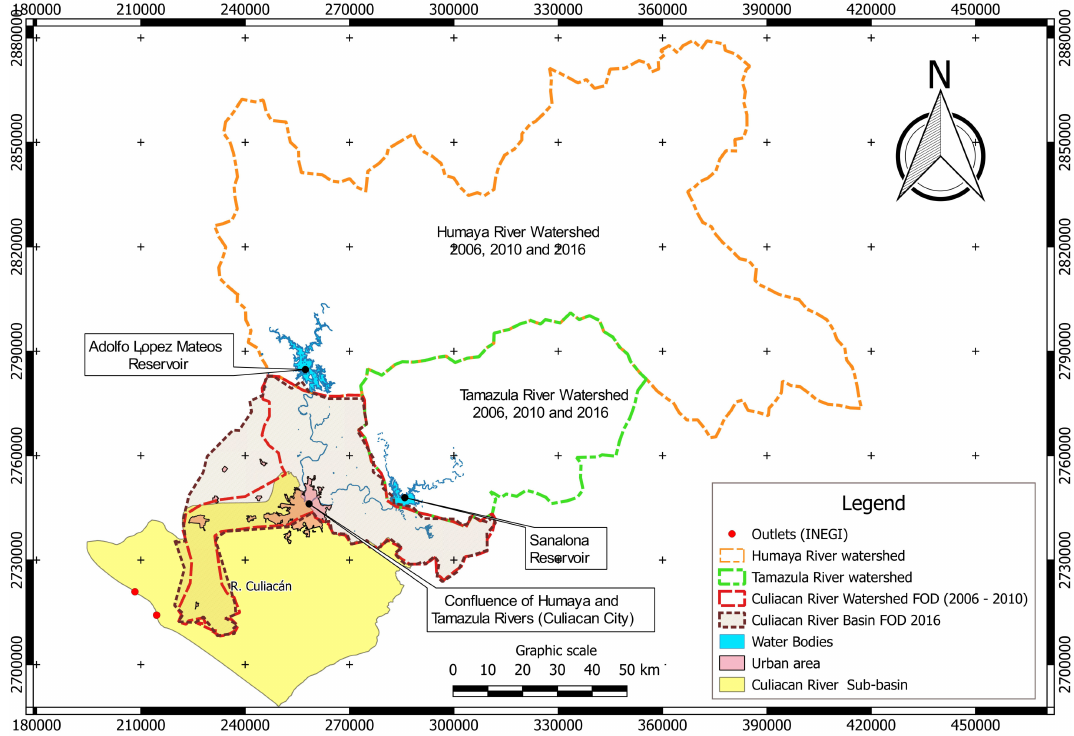
Figure 1. Culiacan River Watershed according to the shape-files of INEGI (2017a) and the coordinates of vertexes published in CONAGUA